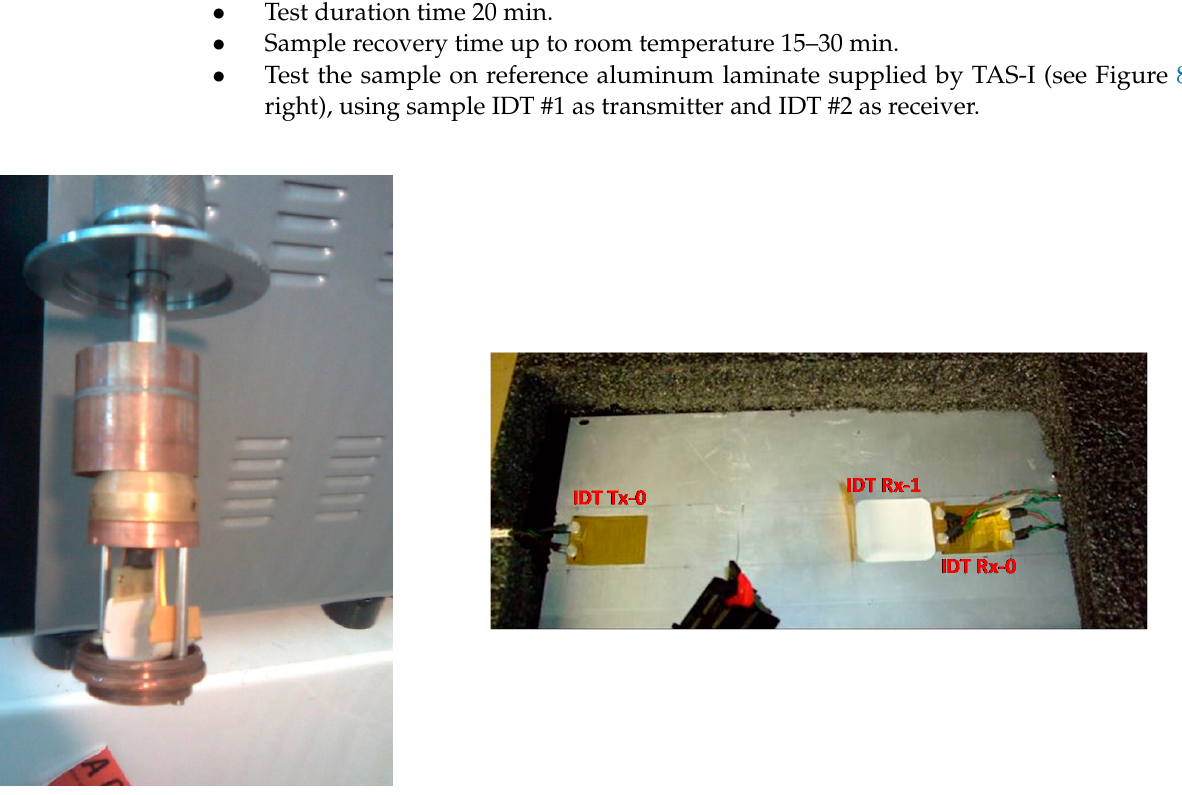
Figure 8. ( Left ) Piezopolymer sensors introduced in the cryogenic chamber. ( Right ) Experimental set up with two piezopolymer transducers in pitch-catch configuration for comparison of performance before and after the cryogenic treatment.